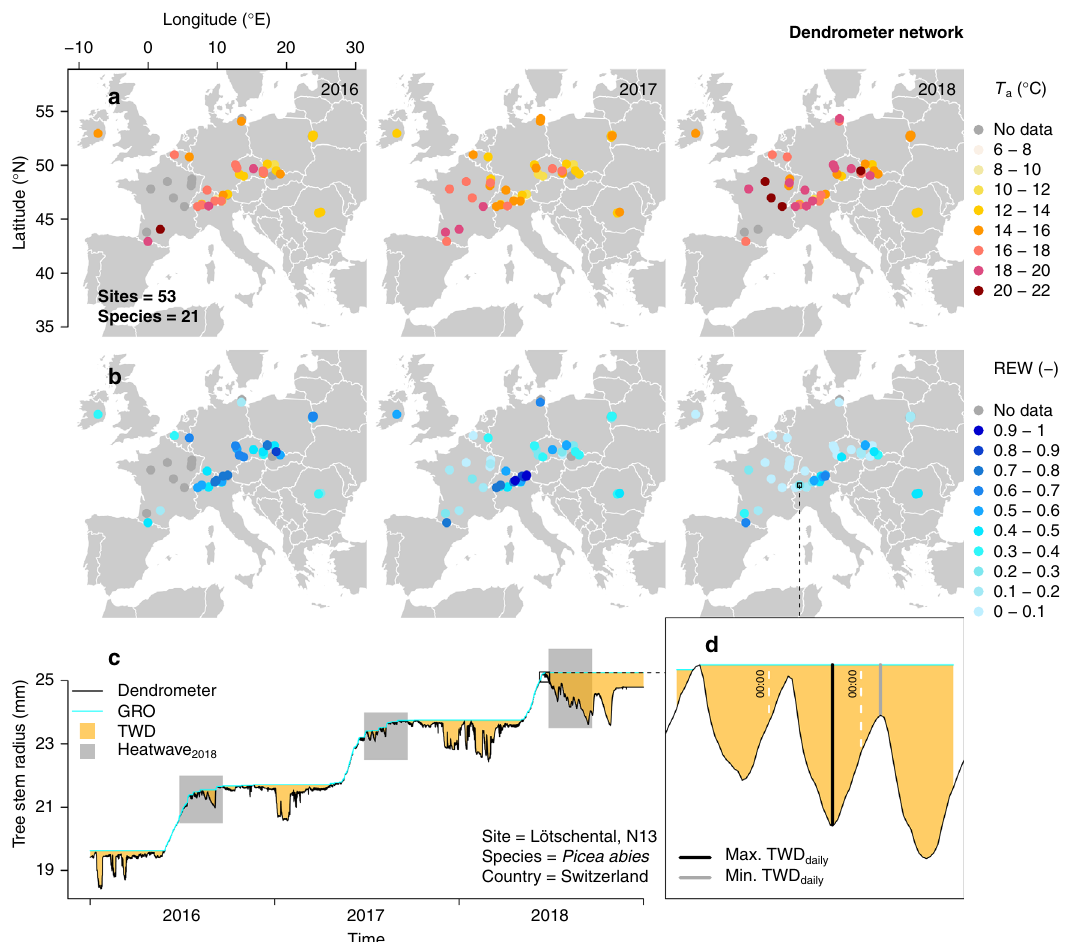
Fig. 1 Climatic conditions during the 2018 heatwave period and dendrometer network. a , b Spatial distribution of dendrometer sites and their respective mean atmospheric temperature ( T a in °C) and relative extractable water (REW) during the 2018 heatwave timeframe (day of year 208 until 264) for 2016 – 2018. Sites with incomplete dendrometer time series data are indicated with grey dots. c Tree stem radius monitored at the Swiss Lötschental (site N13) for a Picea abies (L.) Karst. tree. The period corresponding to the 2018 heatwave is shown in all three years (de fi ned as Heatwave 2018 ), in addition to tree water de fi cit (TWD) and extracted growth (GRO). d Inset of three days of tree stem radius monitored for the P. abies tree, where the concept of daily minimum and maximum TWD is shown (Max. TWD daily and Min. TWD daily ,